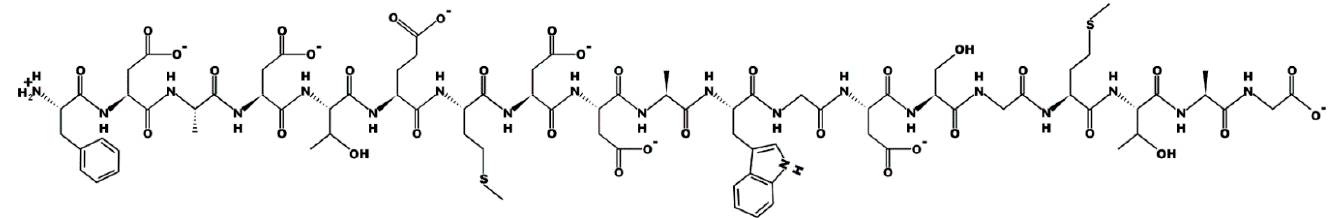
Figure 6. Graphic representation of the amino acid sequence of metabolite fragments of fractions A/1.